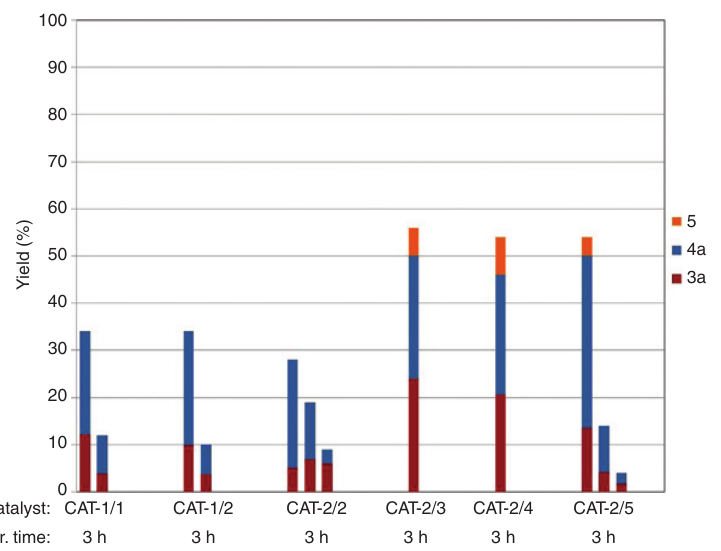
Figure 8: Selectivity and recyclability of catalysts in aminocarbonylation carried out in DMF at atmospheric pressure [0.2 mmol 1 , 0.5 mmol N, catalyst (with 3.6 μ mol Pd-content), 1 ml DMF, 1 bar CO, 100 ° C]. 2a , 0.25 mmol Et 3